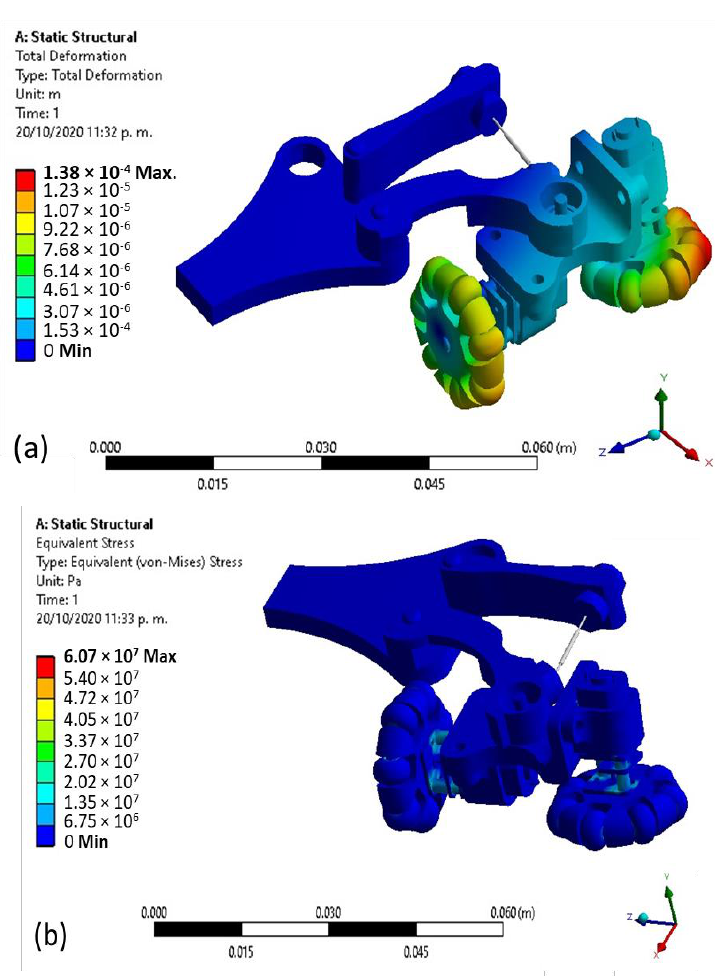
Figure 12. Computed results from structural analysis ( a ) Total deformation. ( b ) Equivalent stress. Electronics for control movements are located outside of the pipe, so engines suffer a cable load and robot weight. Enough cable length is needed to run through the pipe. The normal force that supports the cable and the robot’s mass, the friction force and the robot motion’s net force are involved. The total robot weight is capable of dragging 14.79 kg. By the characteristics of the pipes and requirements mentioned above, a small porta- ble video camera with infrared night vision light can be installed on the robot body to visualize the pipeline in real-time. A screen for monitoring control is installed outside the people under inspection. Camera movement from left to right has been programmed within the control code for actuating a servomotor. The solutions mentioned above are tested as robust according to the requirements; however, there are still disadvantages such as the microgear motors’ dimensions, preventing additional robot size reduction. Work- ing with pipes for stormwater discharge requires airtightness for the actuators, although the coverage with thermofit is insufficient to attack this problem. 3D printing parts for constructing the robot prototype and all electronic components are shown in Figure 13. The wheel dimension is also shown for a closer look at the robot dimensions. Moreover, it shows the robot inside the PVC pipe. After printing each part of the robot, they were joined by means of screws and bearings, depending on whether it